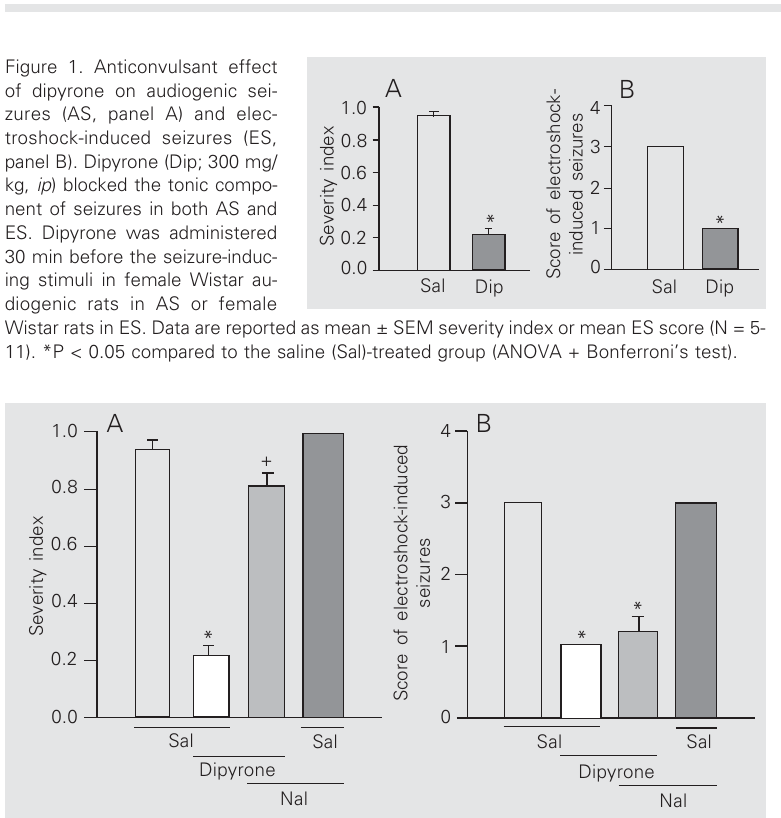
Figure 2. Effect of naloxone on the anticonvulsant action of dipyrone. A , In the audiogenic seizure model, naloxone (5 mg/kg, sc ) reversed the anticonvulsant action of dipyrone (300 mg/kg, ip ). B , In the electroshock-induced seizure model naloxone (5 mg/kg, sc ) did not reverse the anticonvulsant effect of dipyrone. Naloxone (Nal) was administered 10 min before dipyrone. Data are reported as mean ± SEM severity index or electroshock score (N = 5-11). *P < 0.05 compared to the saline (Sal)-treated group and + P < 0.05 compared to the dipyrone-treated group (ANOVA + Bonferroni's test).